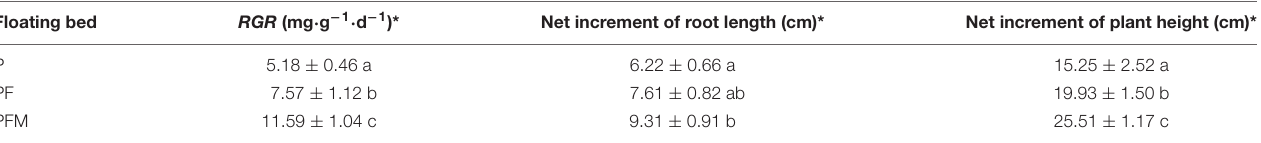
TABLE 2 | Growth characteristics of I. pseudoacorus in the floating beds P, PF, and PFM. Floating bed